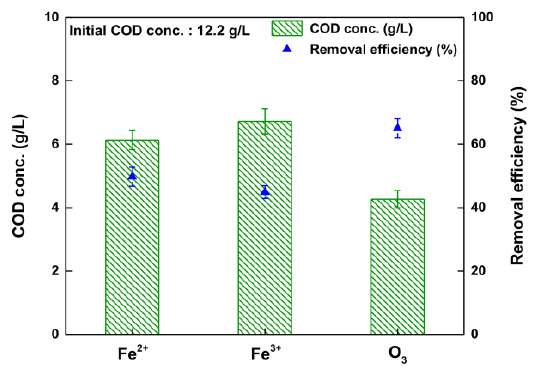
Figure 3. Removal efficiency of COD of Fenton (Fe 2+ ), Fenton-like (Fe 3+ ), and O 3 oxidation.